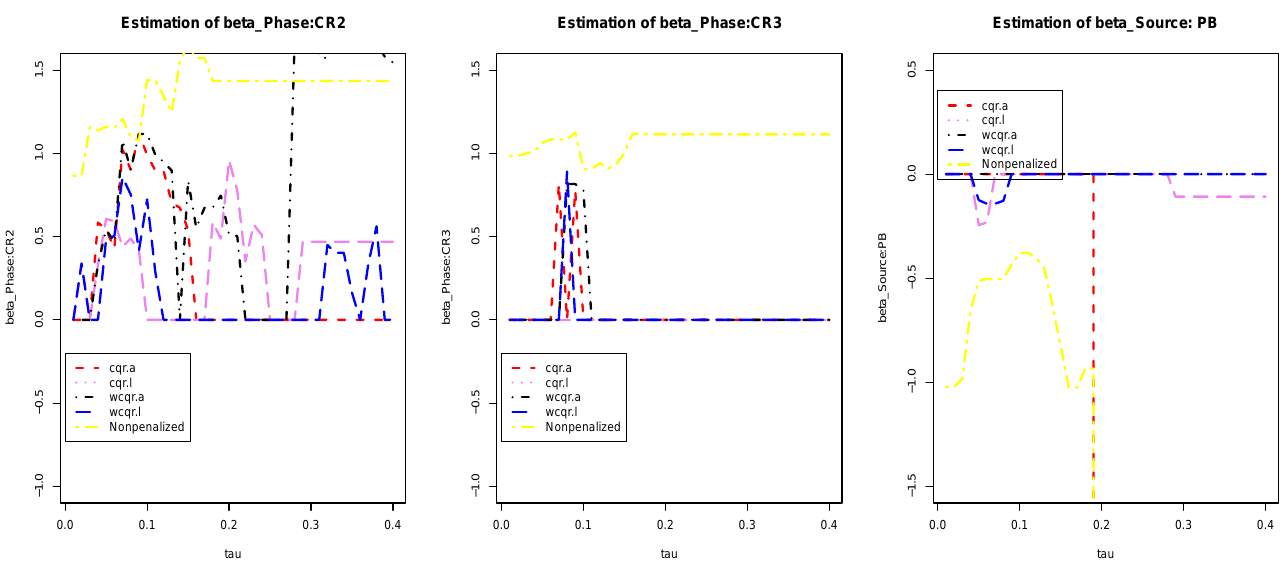
Figure 5. Estimation results for β Phase:CR2 , β Phase:CR3 and β Source:PB .The Y axis reports the coefficient values at different τ . Various colors of lines represent eight methods.